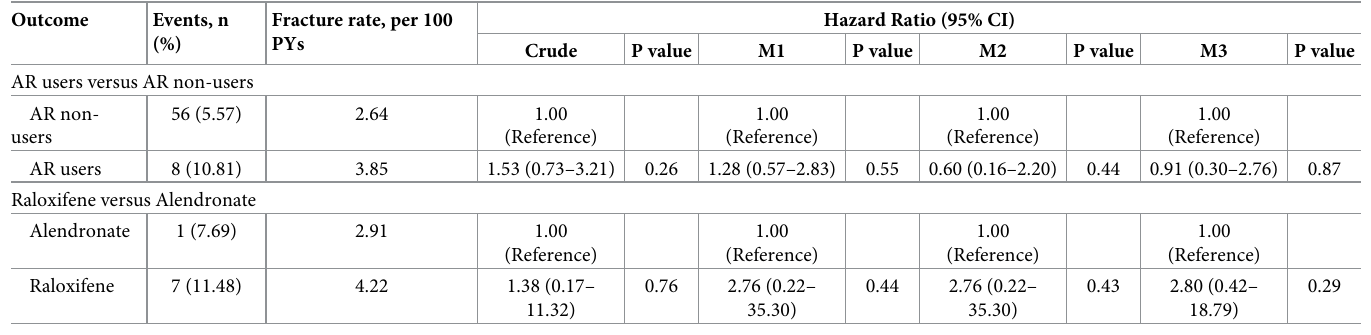
Table 2. Risk of hospitalization for second hip fracture in AR users versus non-users and raloxifene versus alendronate. Outcome